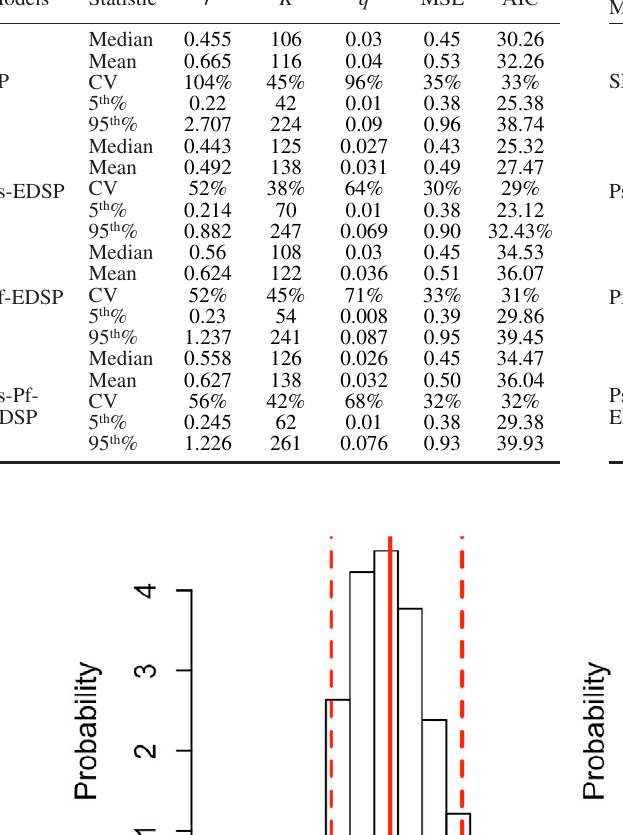
4. – Summary of the estimates of parameters with the boot- strapped ML method from 1500 runs of bootstrap simulation for CPUE and catch data observed from 2003 to 2013 for O. bartramii . For each bootstrap run, mean square error (MSE) was calculated. Models